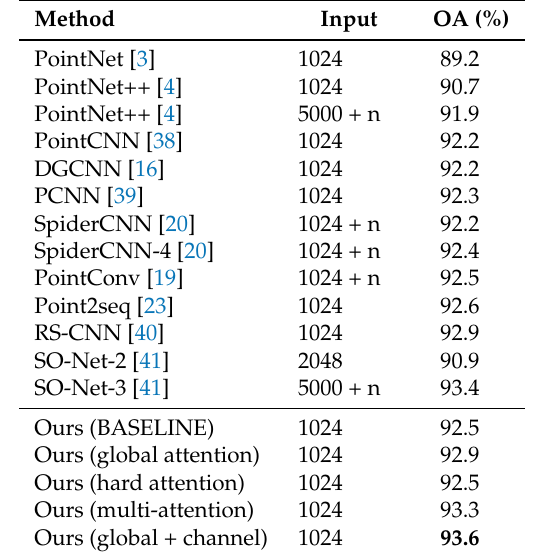
Table 2. Classification results on ModelNet40. (Model- num denotes the model with num layers. + n represents that the input contains normal vectors. OA means the overall